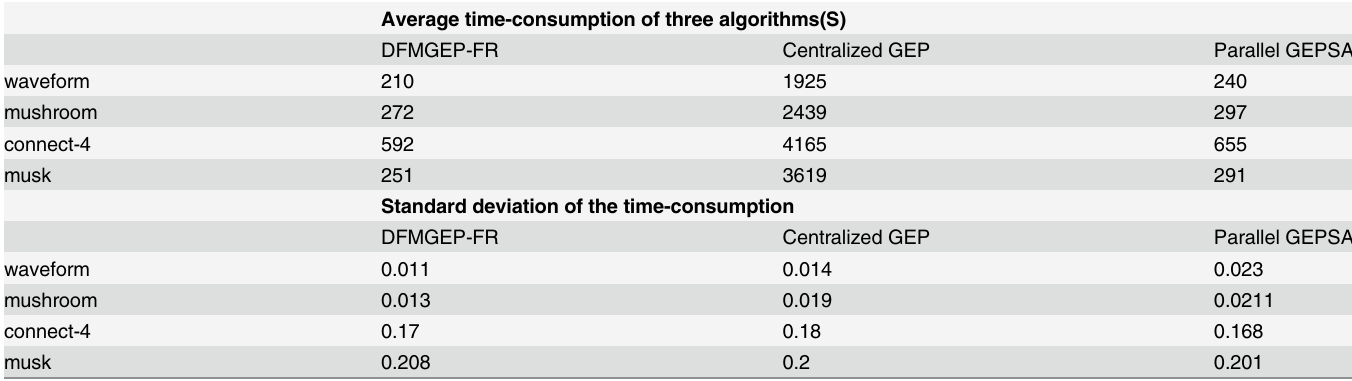
Table 6. Comparison of the average time-consumption and standard deviation of the time-consumption between DFMGEP-FR and other